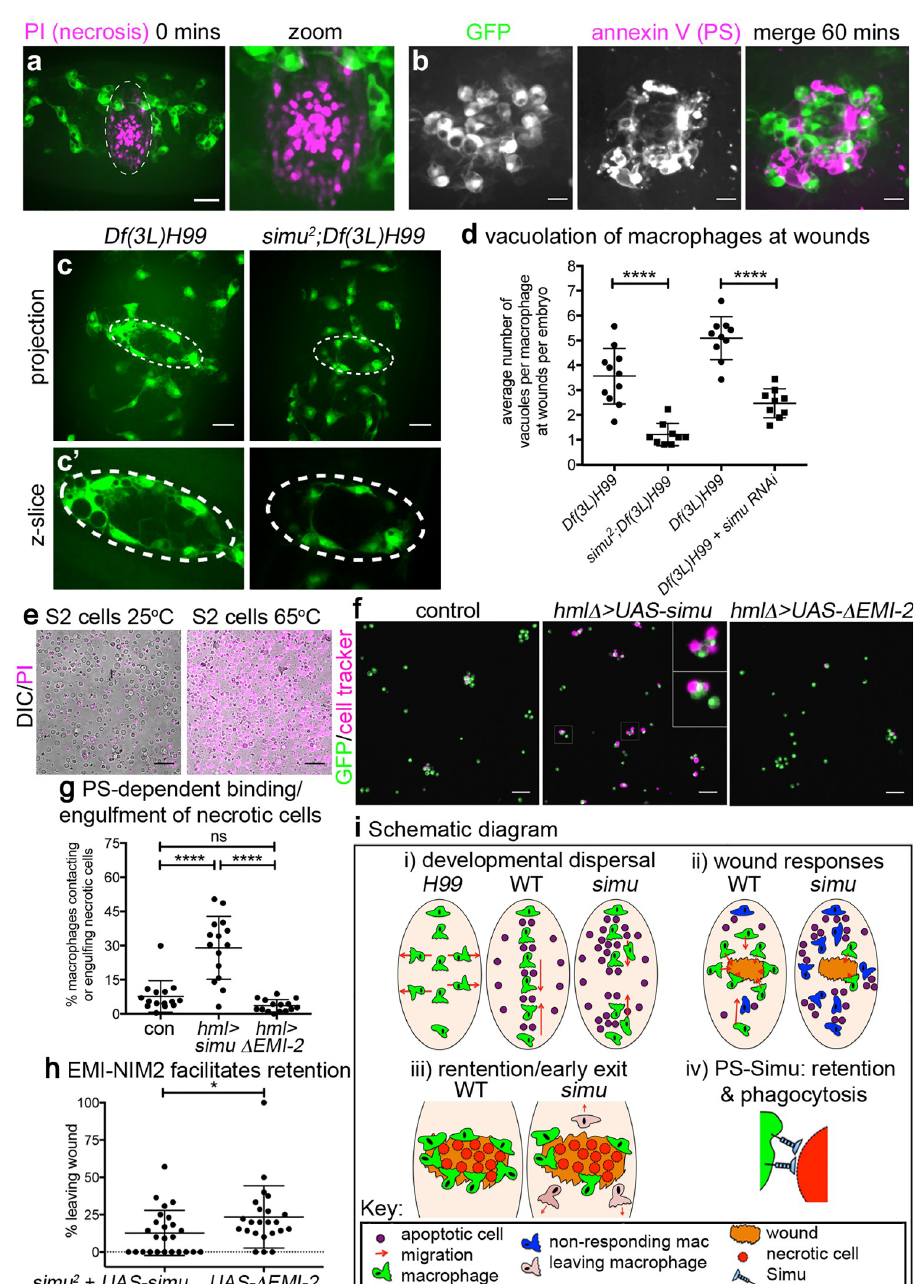
Fig 9. Simu recognises and facilitates removal of necrotic debris at wounds in a PS-dependent manner, preventing early exit of macrophages from sites of inflammation. (a) PI staining to show necrotic cells immediately after wounding in a stage 15 control embryo (GFP-labelled macrophages, green; PI, purple). Dotted lines in left-hand panel show wound edge; right-hand panel shows zoom of wound. (b) Panels show GFP-labelled macrophages (green in merged image), PS staining (via annexin V, purple in merged image) and merged image at a wound site at 60-minutes post wounding of a stage 15 control embryo. (c) Maximum projections of GFP-labelled macrophages in apoptosis-null embryos ( Df(3L)H99 ) and simu mutants that lack apoptosis ( simu 2 ; Df(3L)H99 ) at 60-minutes post wounding; note absence of vacuoles in macrophages away from the wound (indicated via dotted line). (c’) Shows zooms of wound regions taken from single z-slices from image stacks used to make projections in (c). (d) Scatterplot comparing numbers of vacuoles present in macrophages at wounds in apoptosis-null embryos ( Df(3L)H99 ) with apoptosis-null embryos that lack simu ( simu 2 ; Df(3L)H99 ) ( n = 11 and 9, respectively; P < 0.0001, Mann–Whitney test), and apoptosis null embryos with ( Df(3L)H99 + simu RNAi ) or without ( Df(3L)H99 ) macrophage-specific